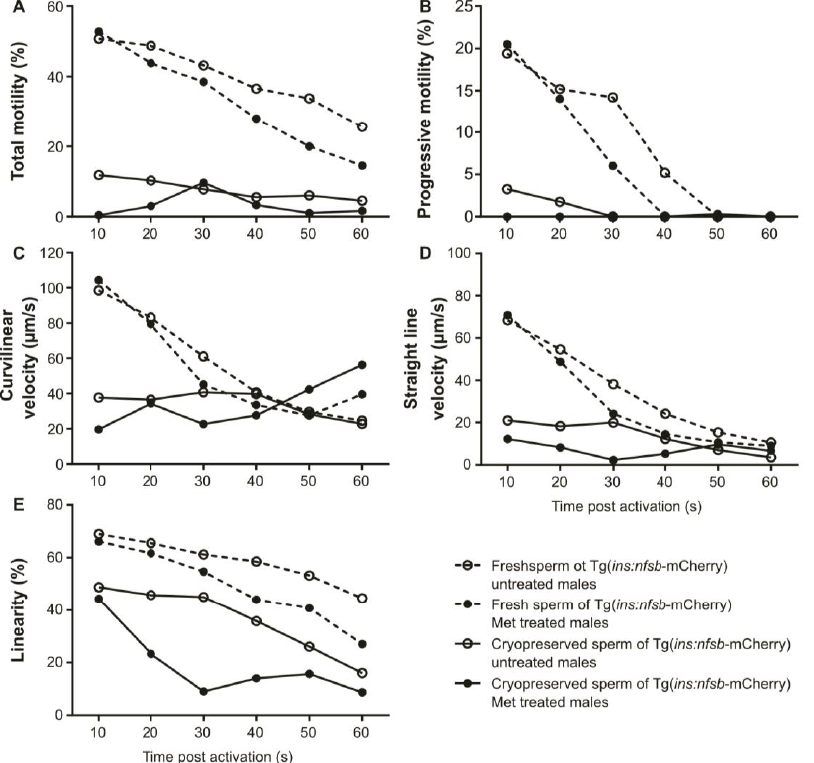
Figure 4. Sperm motility parameters of fresh sperm obtained from untreated Tg( ins : nfsb-mCherry ) males ( n = 5) and metronidazole (Met)-treated males ( n = 8) and of cryopreserved sperm from untreated ( n = 5) and Met-treated males ( n = 10). Sperm was activated, and motility parameters were recorded every 10 s for 1 min in terms of: ( A ) total motility (%); ( B ) progressive motility (%); ( C ) curvilinear velocity ( µ m/s); ( D ) straight-line velocity ( µ m/s), and ( E ) linearity (%). The plotted values represent means. The dashed lines represent fresh sperm and the continuous lines represent cryopreserved sperm. Sperm from untreated males is represented with a white circle and sperm from Met-treated males is represented with a dark